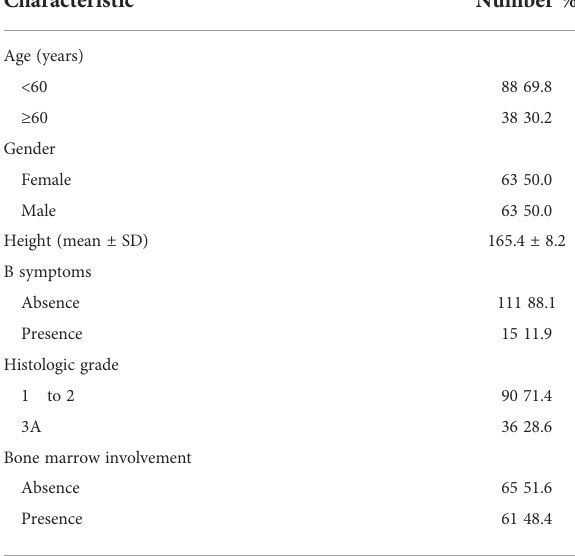
TABLE 1 Characteristics of follicular lymphoma